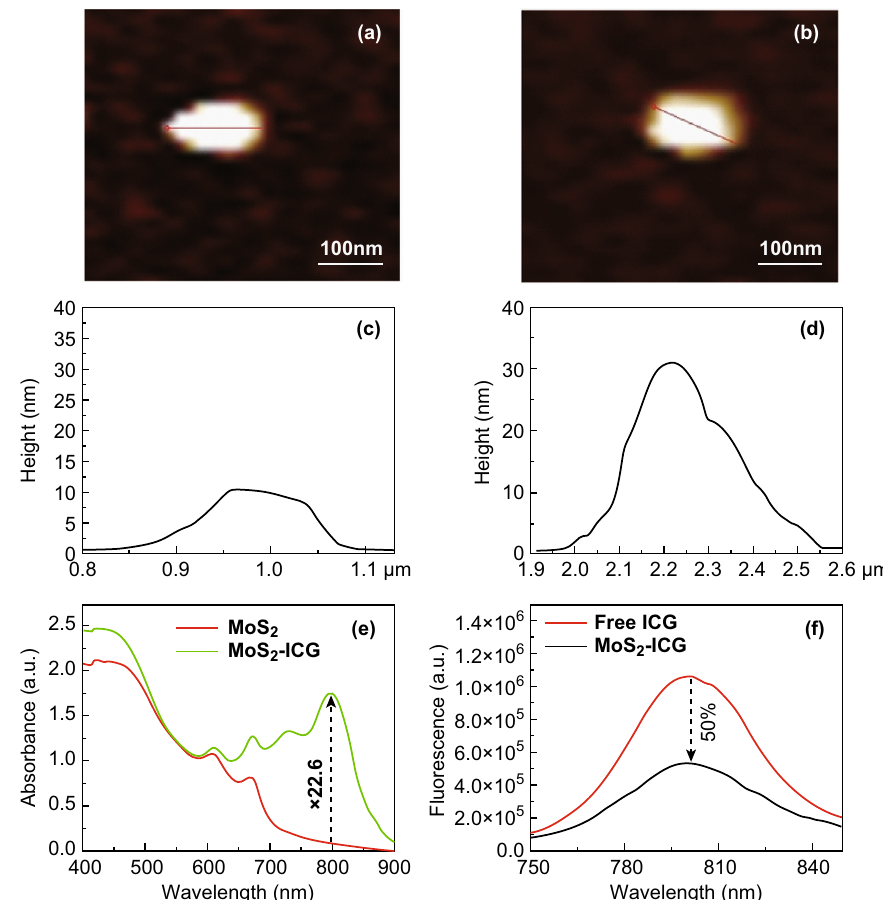
Fig. 1 a , b AFM images and c, d thickness profiles of MoS 2 ( a, c ) and MoS 2 –ICG ( b, d ). e Absorbance spectra of MoS 2 and MoS 2 –ICG at the same concentration of MoS 2 . f Fluorescence spectra of free ICG and MoS 2 –ICG at the same concentration of